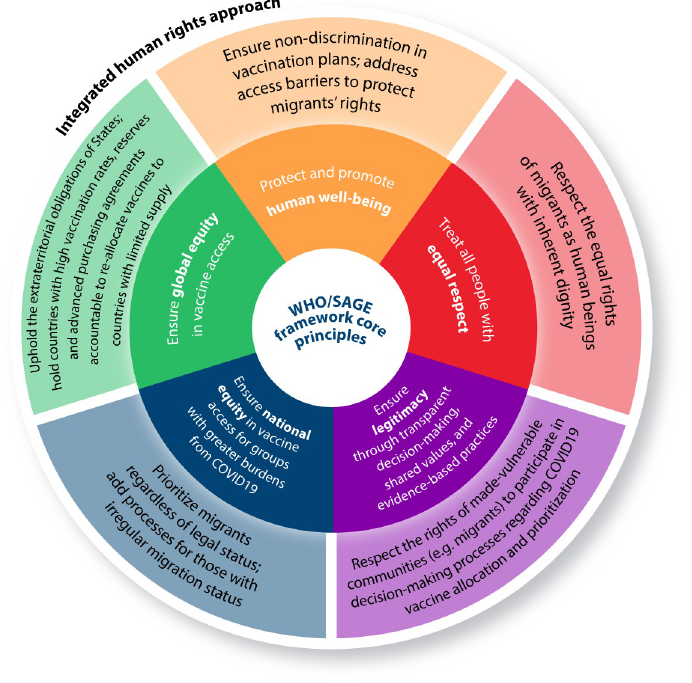
Fig 1. Integrating human rights into a modified WHO/SAGE framework to address the unmet COVID-19 needs of migrants. Inner circle: Summary of select principles in the WHO/SAGE framework. Outer circle: Integrating human rights with WHO/SAGE to promote equitable access to COVID-19 vaccines for